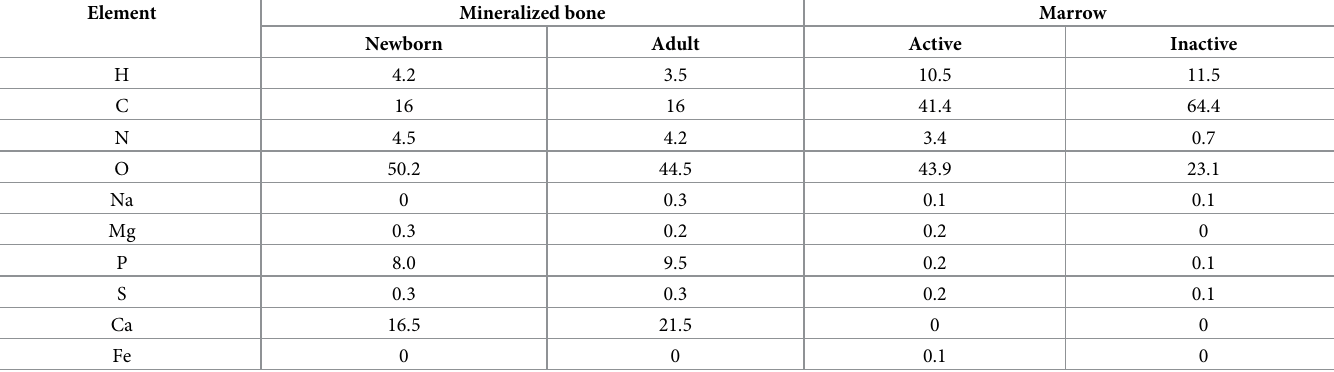
Table 4. Elemental composition of mineralized bone of newborns and adults and also active and inactive marrow of humans in all ages (% by mass) according to [60].